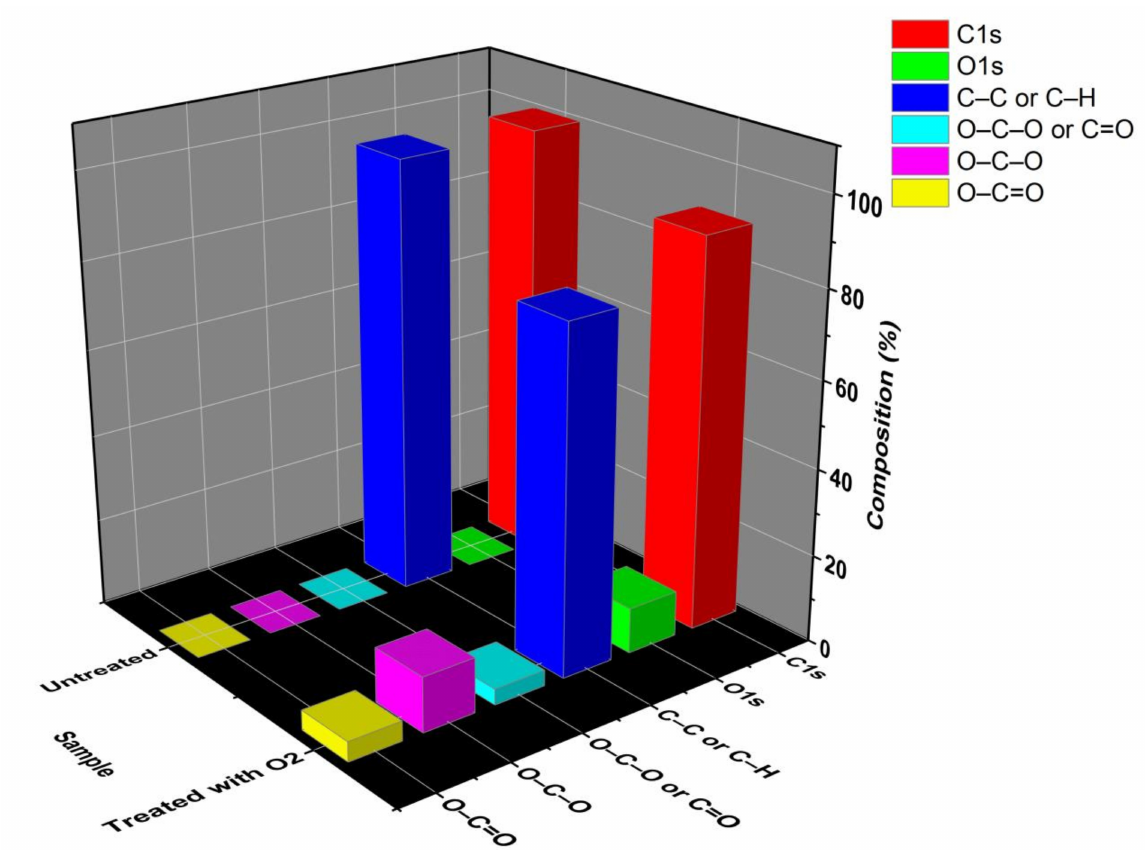
Figure 11. Average percentages of the binding obtained by